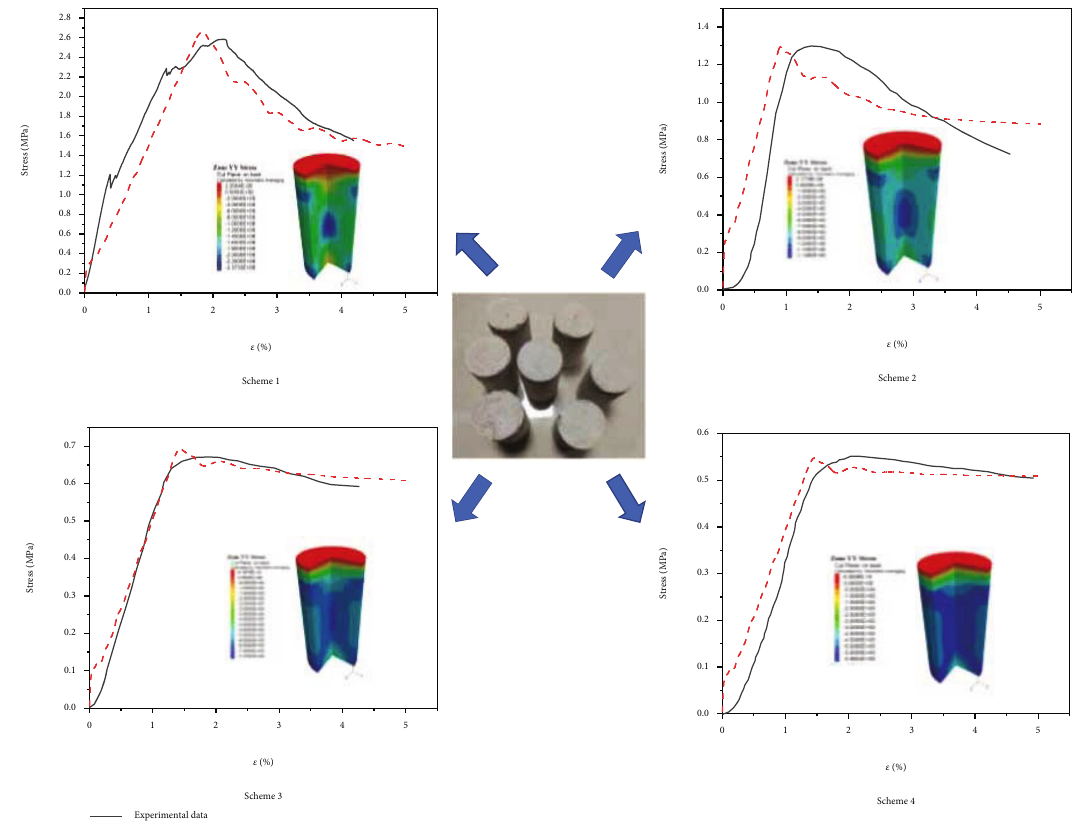
Figure 5: Checking the parameters of paste fi lling material. Table 1: Simulated mechanical parameters of paste materials. Water-cement Scheme number